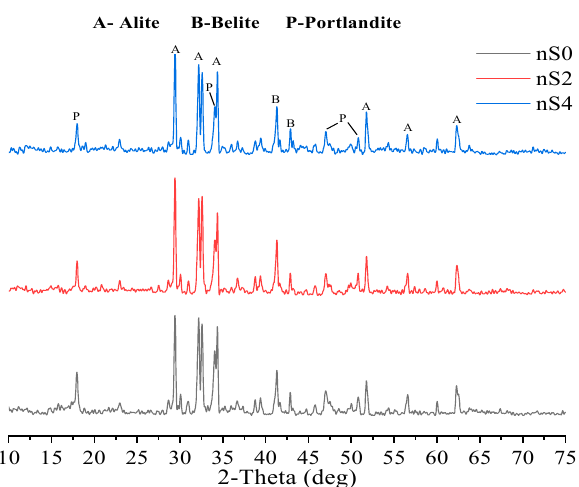
Figure 8. XRD patterns of UHSC casting for 28 days.